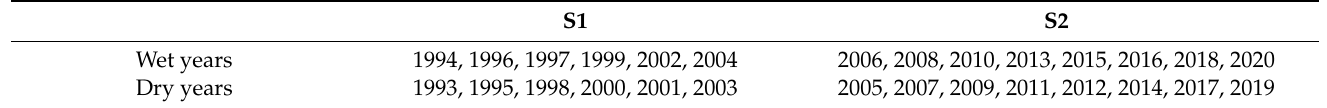
Figure 2. Time series of detrended summertime precipitation over SC during S1 and S2. Table 1. Wet and dry years picked out in S1 and S2 based on the detrended summertime main precipitation larger and smaller than 0,